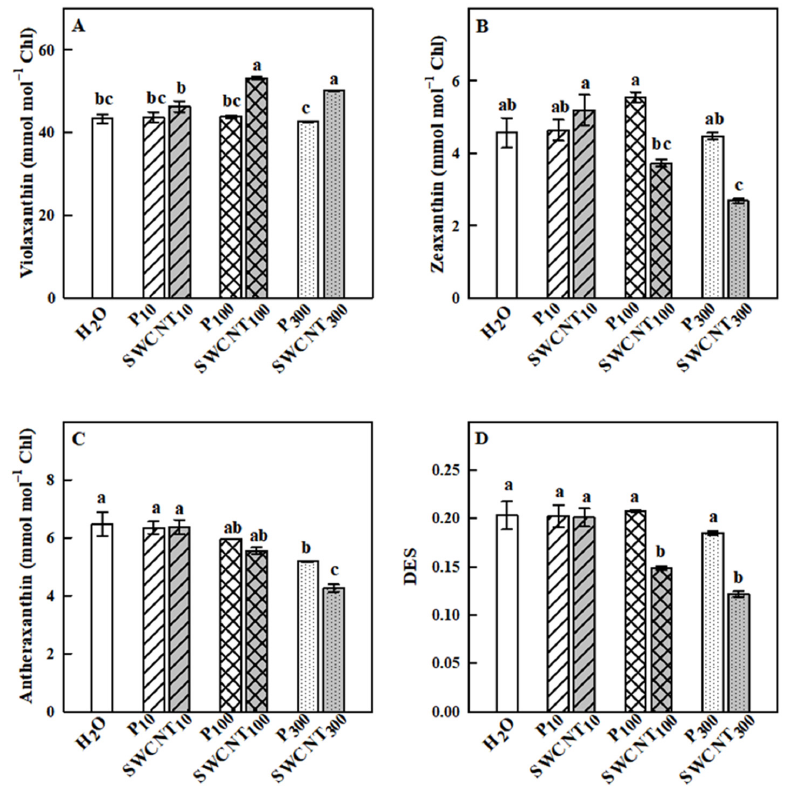
Figure 7. Effect of SWCNTs on xanthophyll cycle pigments. Concentration of violaxanthin ( A ), zeaxanthin ( B ), antheraxanthin ( C ) and the deepoxidation state of xanthophyll pigments (DES, D ) of pea plants seven days after spraying with different concentrations of “Pluronic” P–85 (P 10,100,300 ) and SWCNTs (SWCNT 10,100,300 ). Plants sprayed with H 2 O served as the control. Data are means ± SE ( n = 6). One-way analysis of variance (ANOVA) with a between-subjects factor was performed to assess statistically significant mean differences. Mean separation was performed using a Tukey’s test and statistically different means at the 5% level ( p < 0.05) are indicated with different letters.